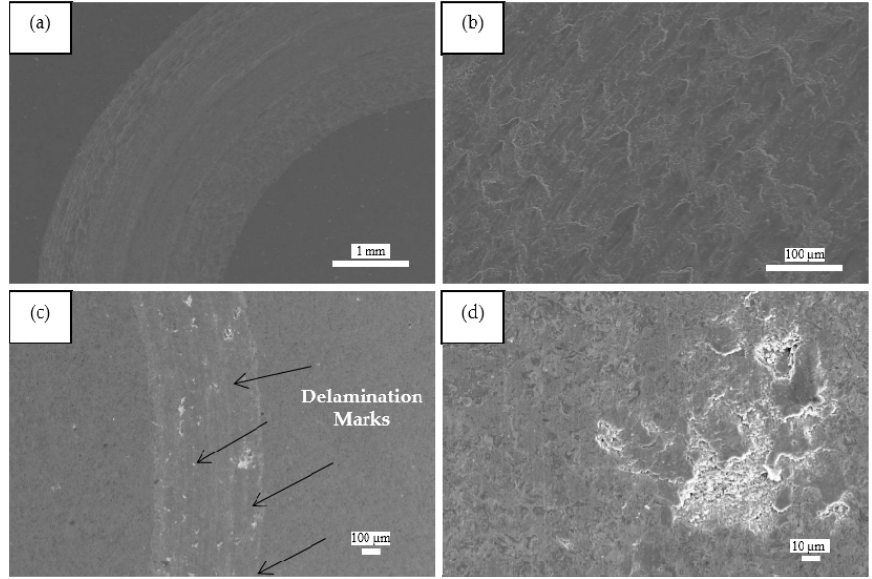
Figure 10. SEM images of the sliding wear tracks of ( a , b ) unreinforced Fe 3 Al and ( c , d ) Fe 3 Al–50 vol. % TiC coatings. Arrows on ( c ) show some delamination marks.